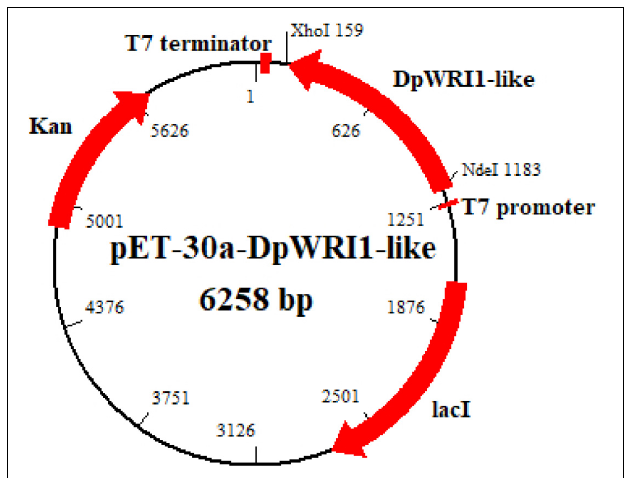
FIGURE 1 | Construction of recombinant expression vector pET-30a-DpWRI1-like. DpWRI1-like gene was cloned into pET-30a vector at restriction enzyme sites (5 (cid:48) end Nde I and 3 (cid:48) end Xho I) under the control of T7